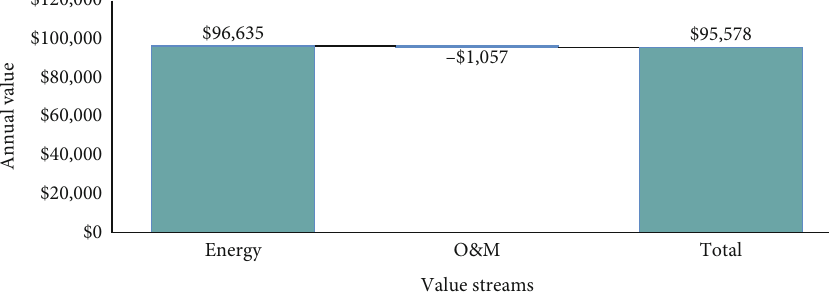
Figure 11: Categorized annual savings for the proposed system for